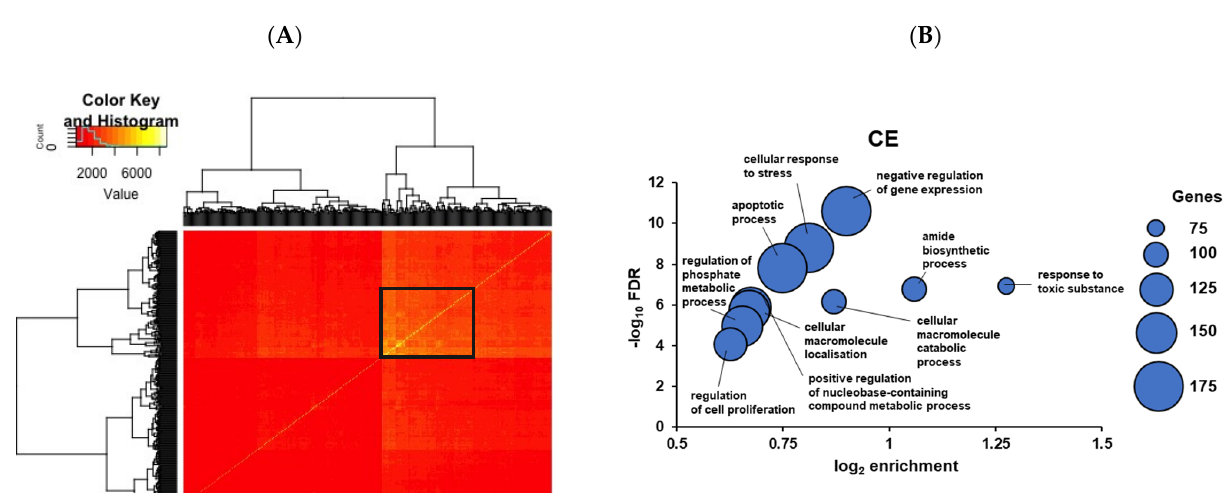
the sample matching the GO term.